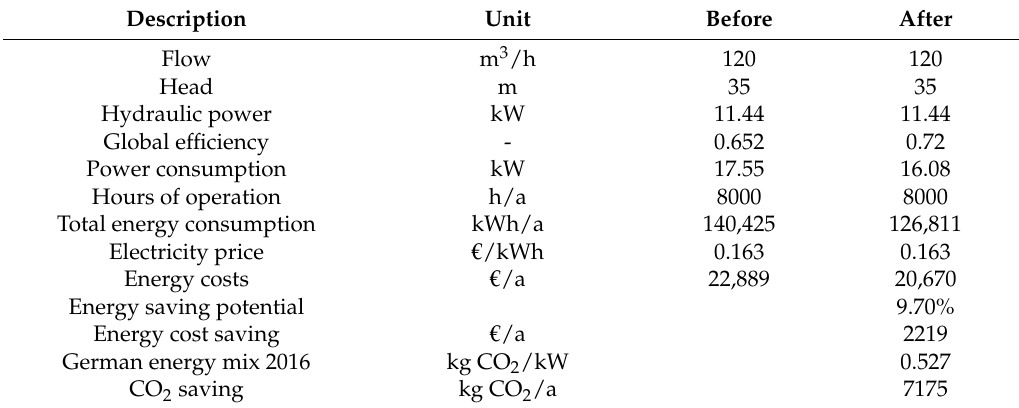
Table 1. Energy saving potential with global efficiency increase by the new PMSM well pump. Description